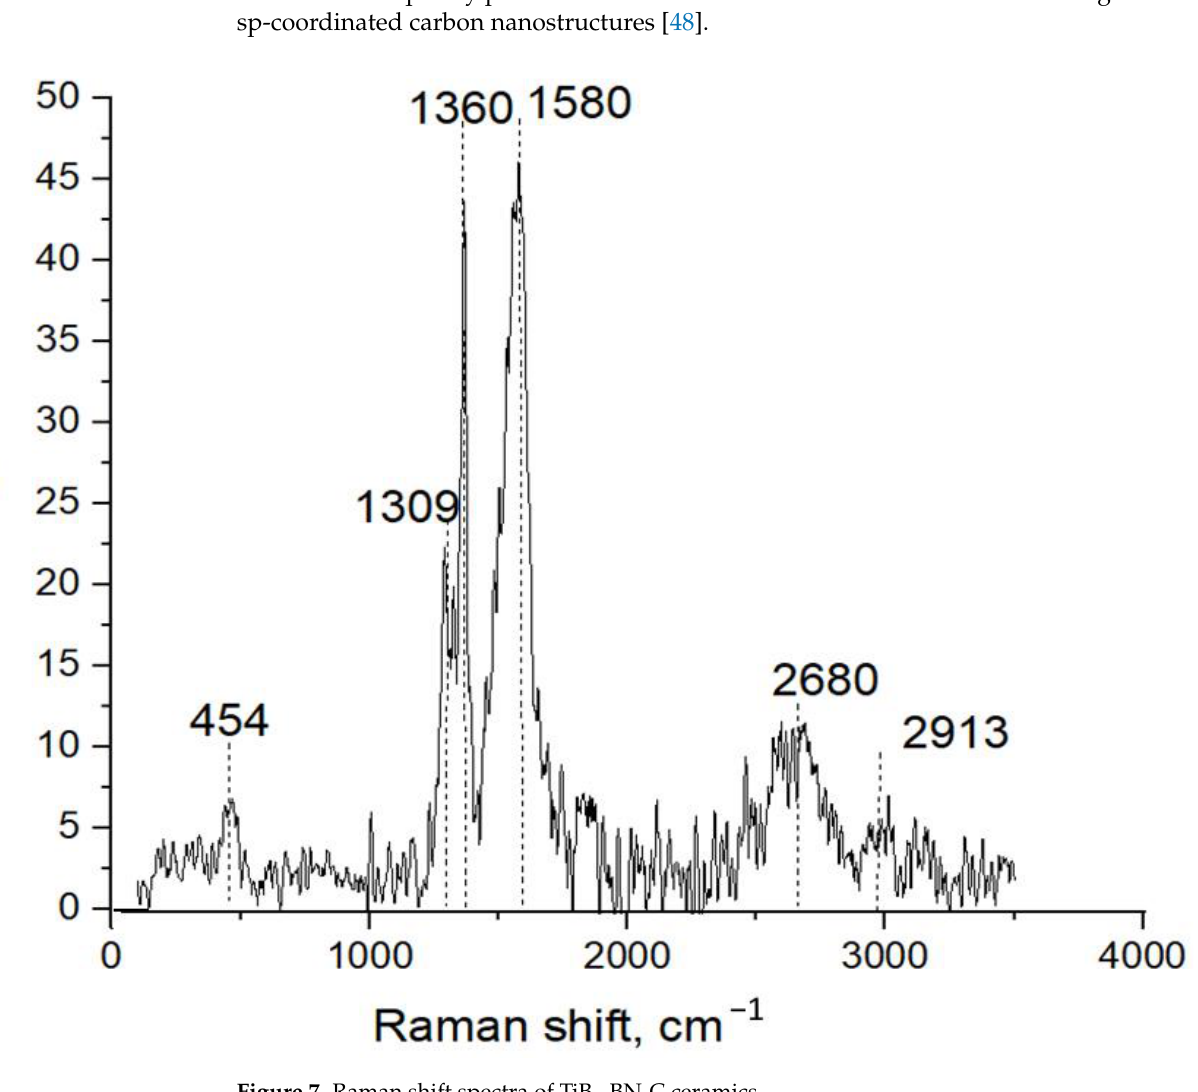
Figure 7. Raman shift spectra of TiB 2 -BN-C ceramics.